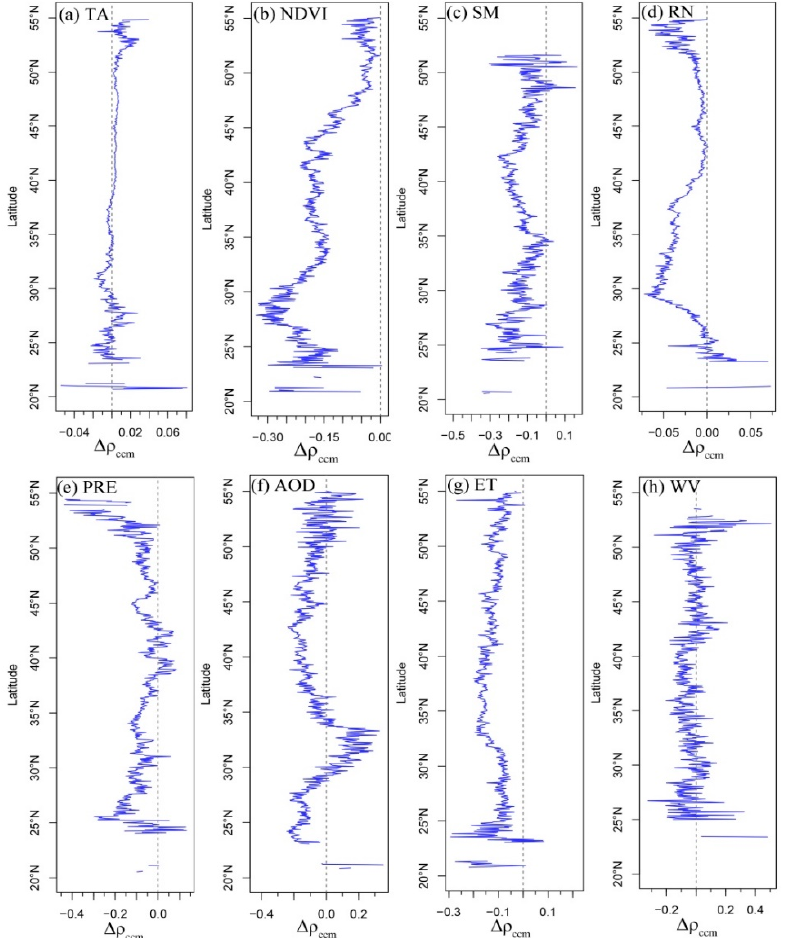
Figure 16. Differences between the two-way convergent cross-mapping skills of LST and each environmental factor. ( a ) TA ( b ) NDVI ( c ) SM ( d ) RN ( e ) PRE ( f ) AOD ( g ) ET ( h ) WV. ∆ ρ ccm = ρ ccm (factor drive LST) − ρ ccm (LST drive factor).